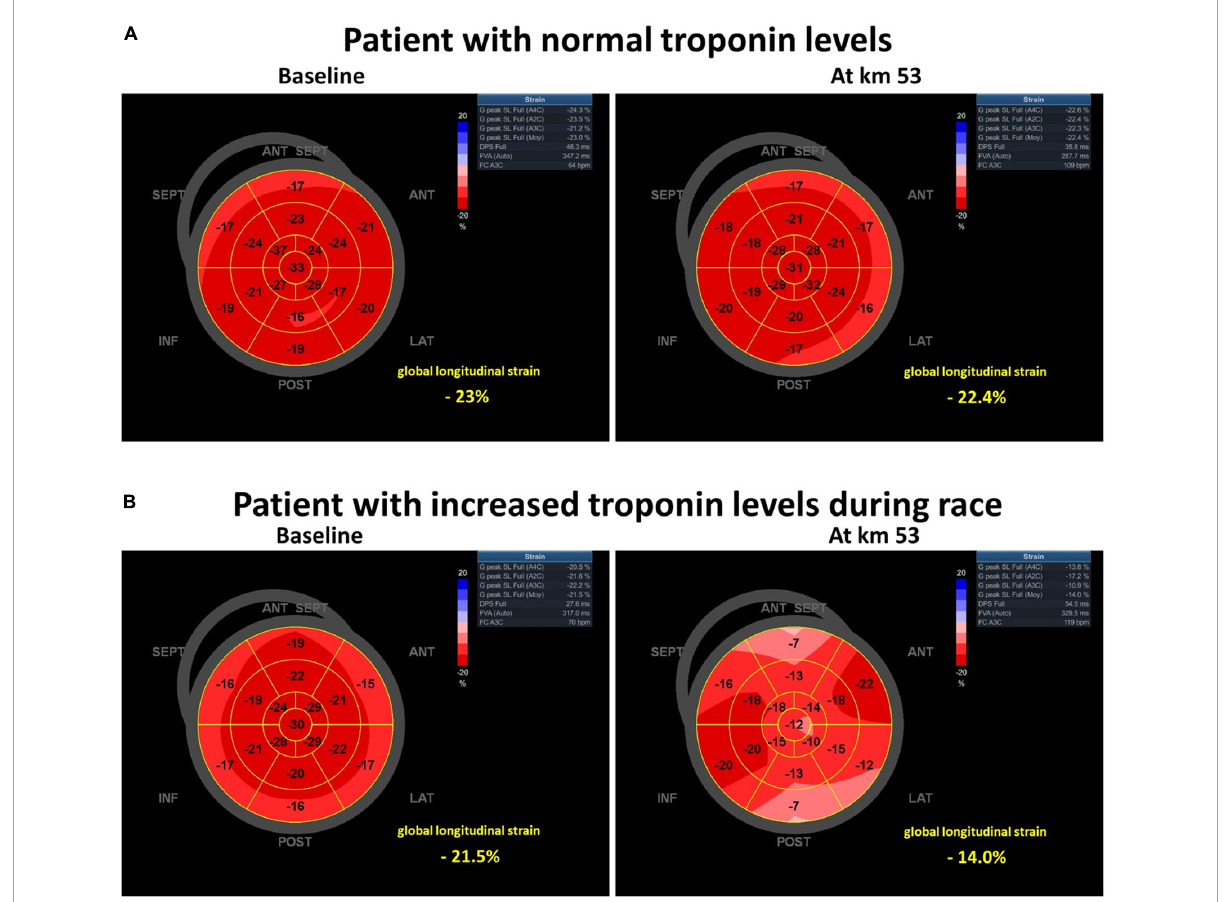
FIGURE2 Pattern of global longitudinal strain (at baseline and at km 53), in a subject (A) with normal troponin levels and no left ventricular systolic dysfunction during the race and in a subject (B) presenting with increased troponin levels and left ventricular systolic dysfunction during